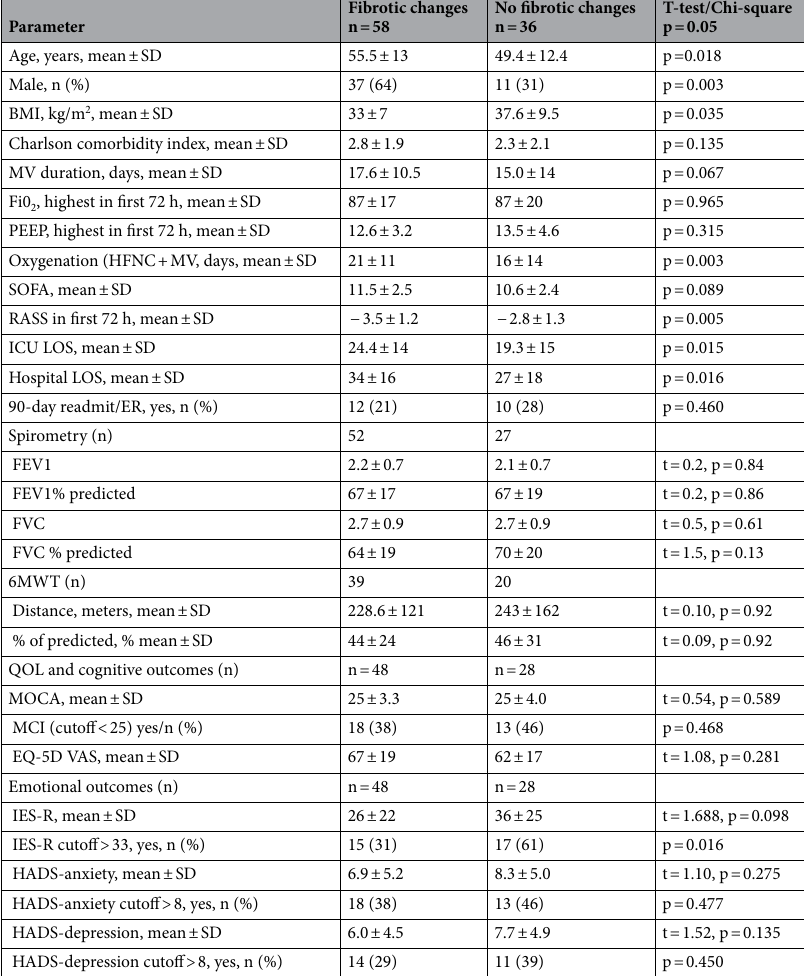
Table 3. Clinical variables and patient-outcomes grouped by fibrotic changes on CT images at short-term follow-up. MOCA Montreal Cognitive Assessment, MCI mild cognitive impairment, VAS visual analog scale, HADS hospital anxiety and depression scale, IES-R impact of events scale-revised, PTSD post-traumatic stress